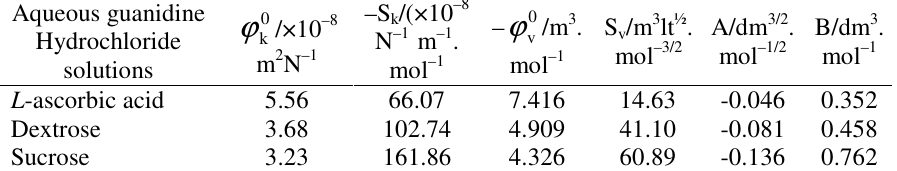
), limiting apparent molal K